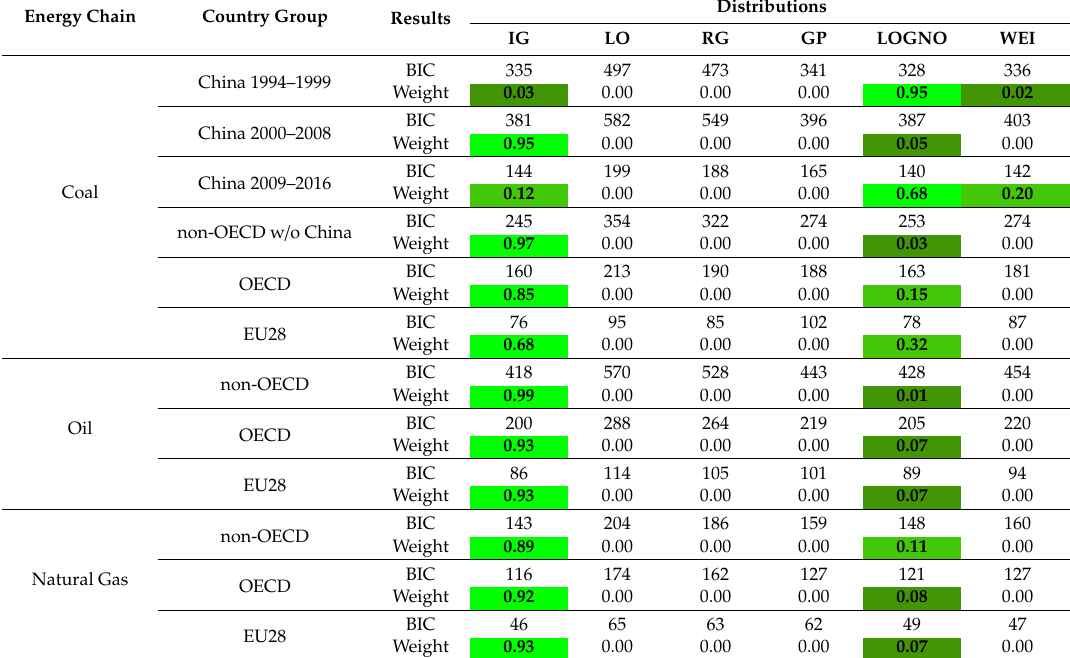
Table 4. Summary of goodness of fit (BIC score) and relative posterior model weight (Weight) for the fatality distributions collected for di ff erent fossil energy chains disaggregated by country groups. In bold: the weights of each model contributing equal or more than 0.01%, and thus, selected for further analysis. The green cells highlighted the di ff erent contribution of each model (the lighter the higher). LO = Logit; RG = Reverse Gumbel; GP = Generalized Pareto; LOGNO = Log-Normal; WEI = Weibull; IG = Inverse